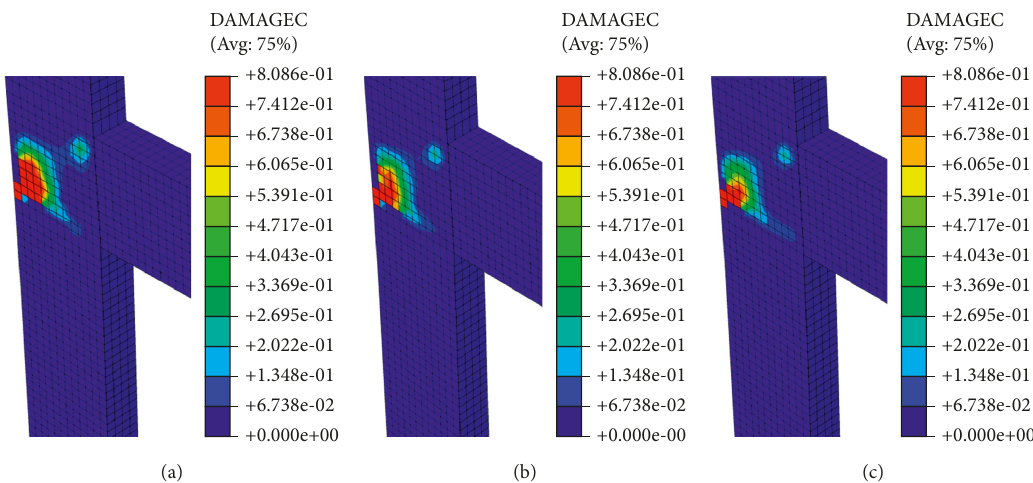
Figure 28: Concrete compression damage for specimens with different joint stirrup ratios: (a) Referential, no shear reinforcement; (b) G5M1, 0.85%; and (c.) G5M2,